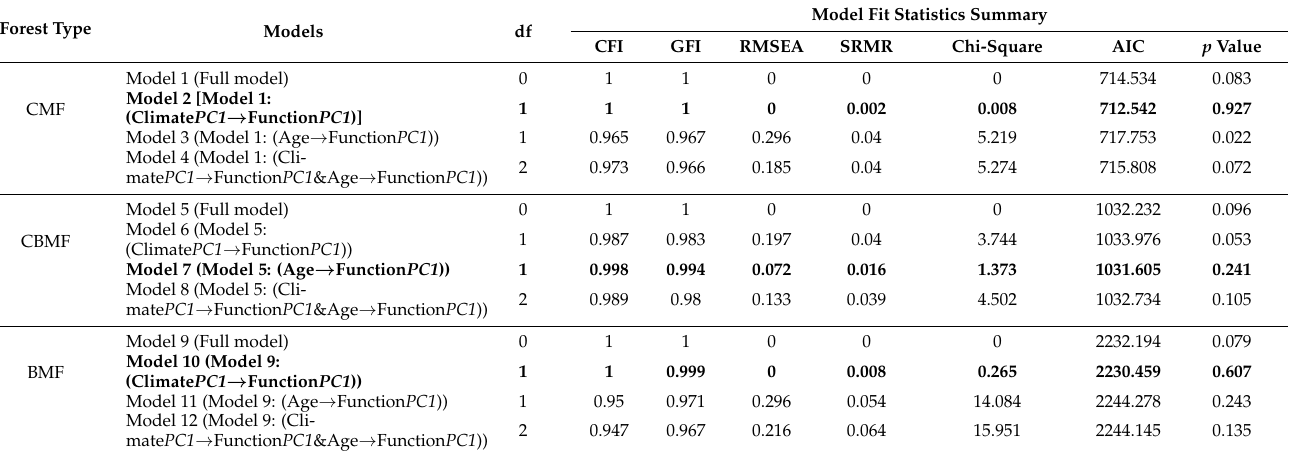
Table 1. SEMs of aboveground wood carbon (AWC) of mixed coniferous forests (CMF), coniferous– broadleaf mixed forest (CBMF), and broadleaf mixed forests (BMF). Model in bold font represents the final causal model used in this